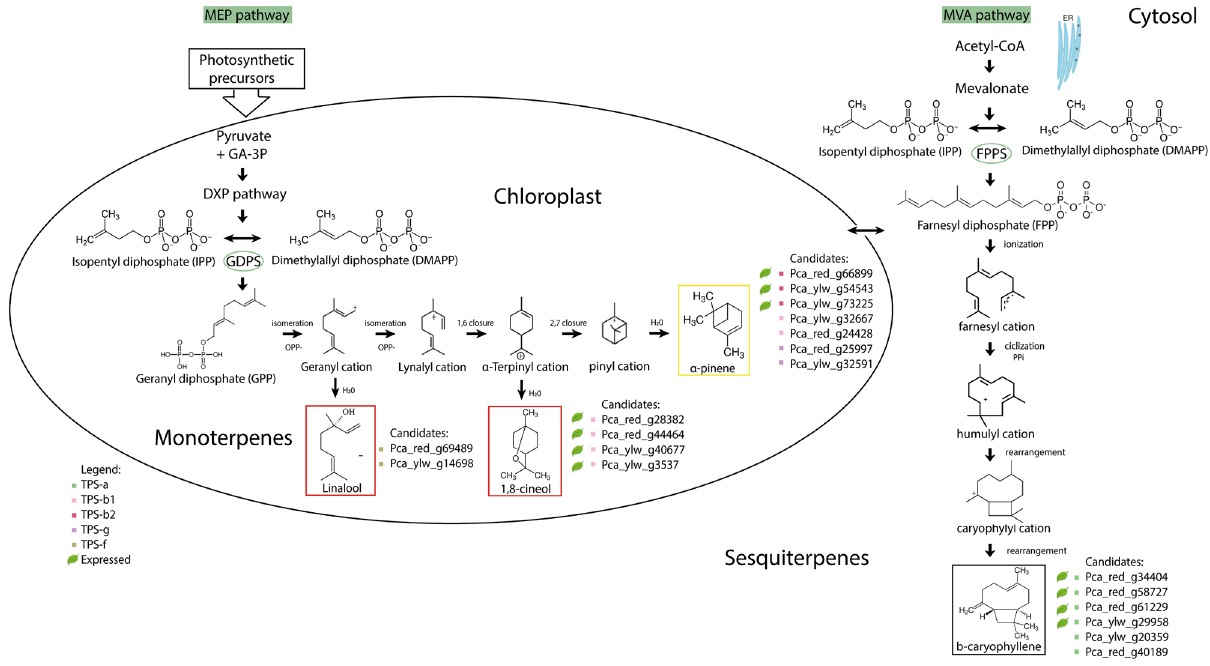
Figure 6. A schematic view of putative terpene synthase genes involved in α-pinene, 1,8-cineol, linalool and β-caryophyllene biosynthesis in P. cattleyanum red and yellow morphotypes. DXP 1-deoxylulose 5-phosphate, DMAPP dimethylallyl diphosphate, IPP isopentenil diphosphate, GPPS geranyl diphosphate synthase, GPP geranyl diphosphate, FPPS farnesyl diphosphate synthase, FPP farnesyl diphosphate, ER endoplasmic reticulum, MEP methyl erythritol 4-phosphate pathway, MVA mevalonate